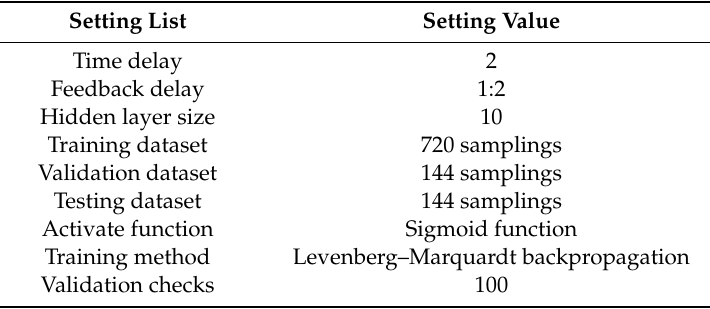
Table 3. NARX Network